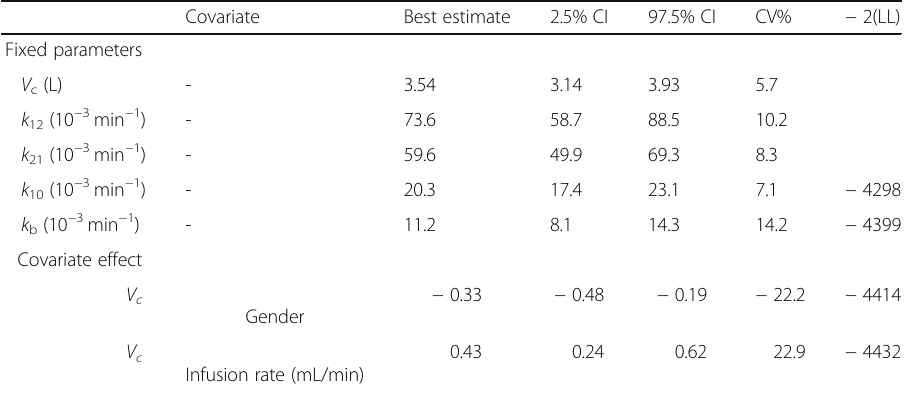
Table 3 Population kinetic parameters in the final model for infusion experiments in the extended analysis of 91